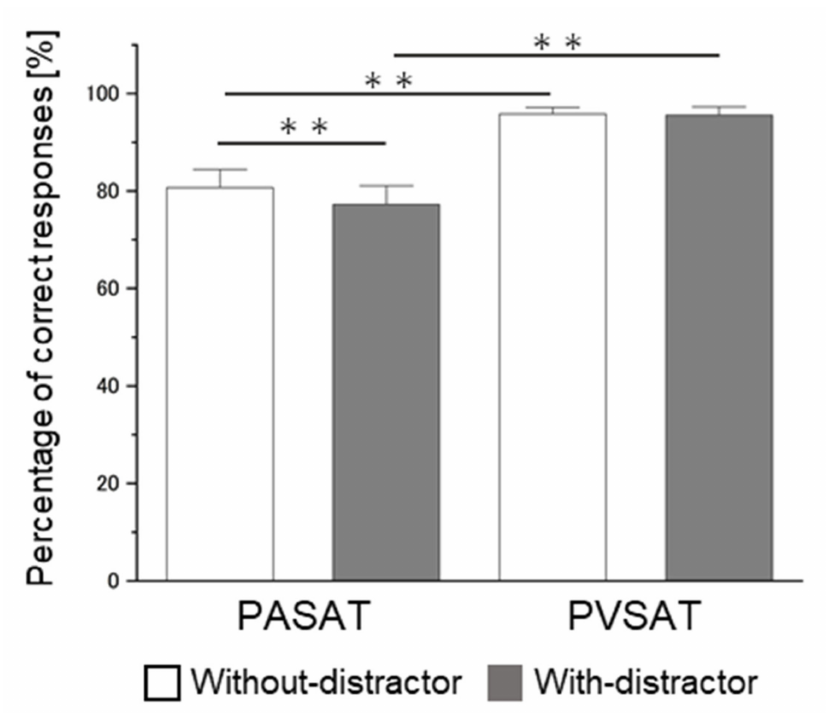
Figure 4. Results of the 2 × 2 analysis of variance of the percentage of correct responses (%) in the PSATs. Error bars indicate the standard error. PASAT, Paced Auditory Serial Addition Test; PVSAT, Paced Visual Serial Addition Test. ** p <